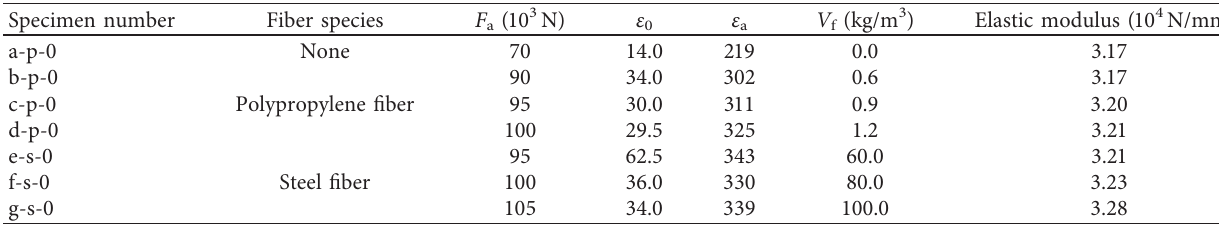
Figure 10: (a) Data fitting of R _ ε of PFRC. (b) Data fitting of R p and lg Table 6: Test results of static elastic modulus